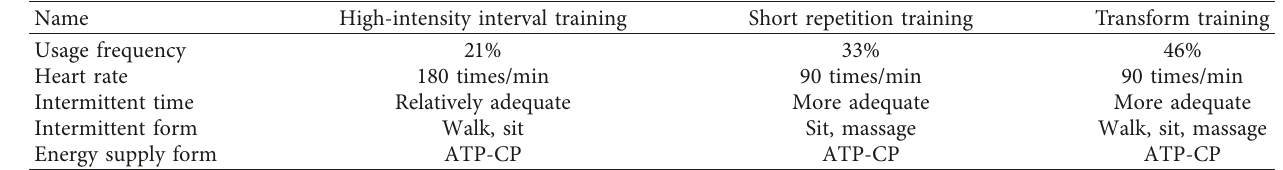
Figure 8: Class schedule for physical training: (a) class schedule for physical training parts and (b) class schedule for physical fitness training quality. Table 2: Main training methods used in physical training.